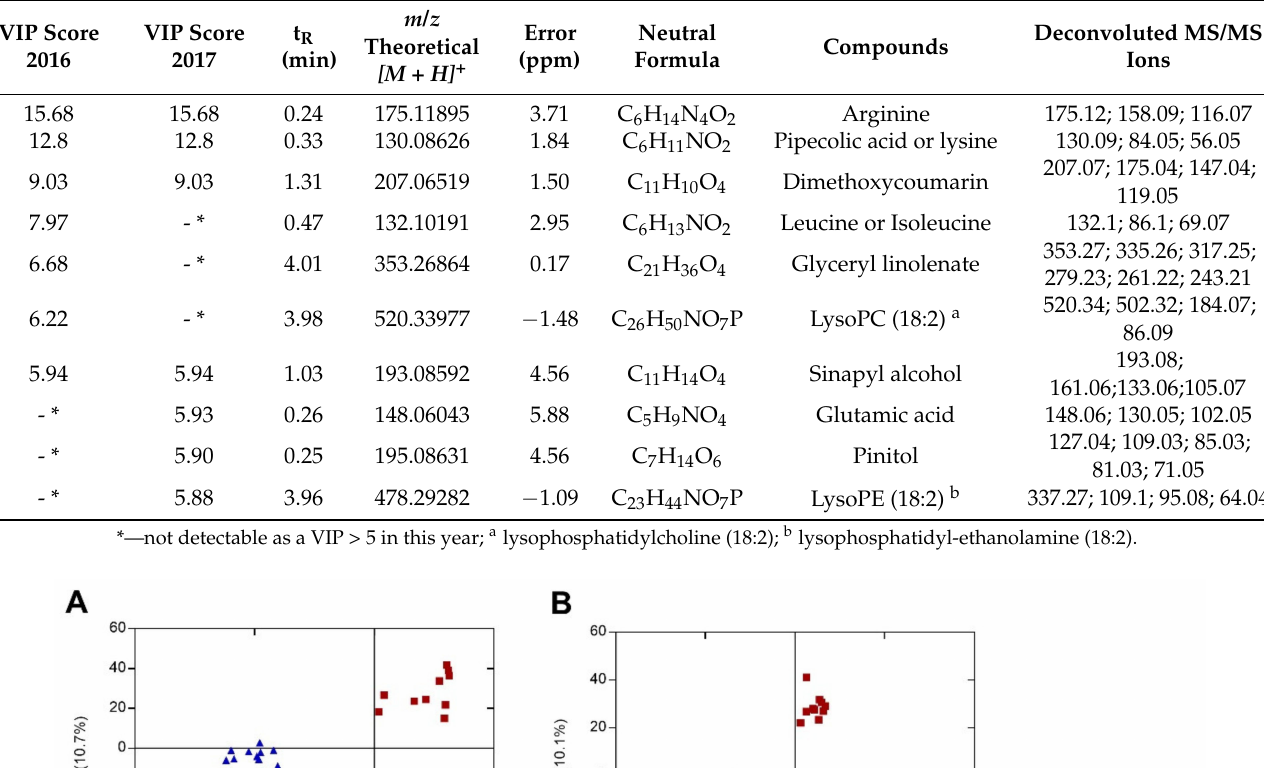
Table 1. Discriminant compounds of the V. album ssp. album groups obtained by PLS-DA model.